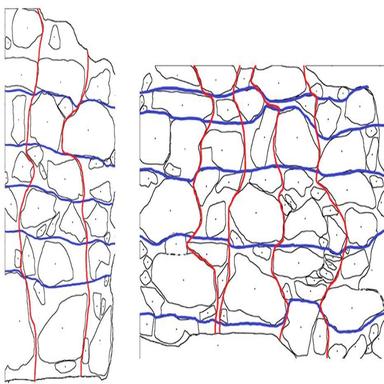
Representation of several shortest paths along the horizontal (blue) and vertical joints (red) (left: MW1 panel; right: MW9 panel). (For interpretation of the references to color in this figure legend, the reader is referred to the web version of this article.)